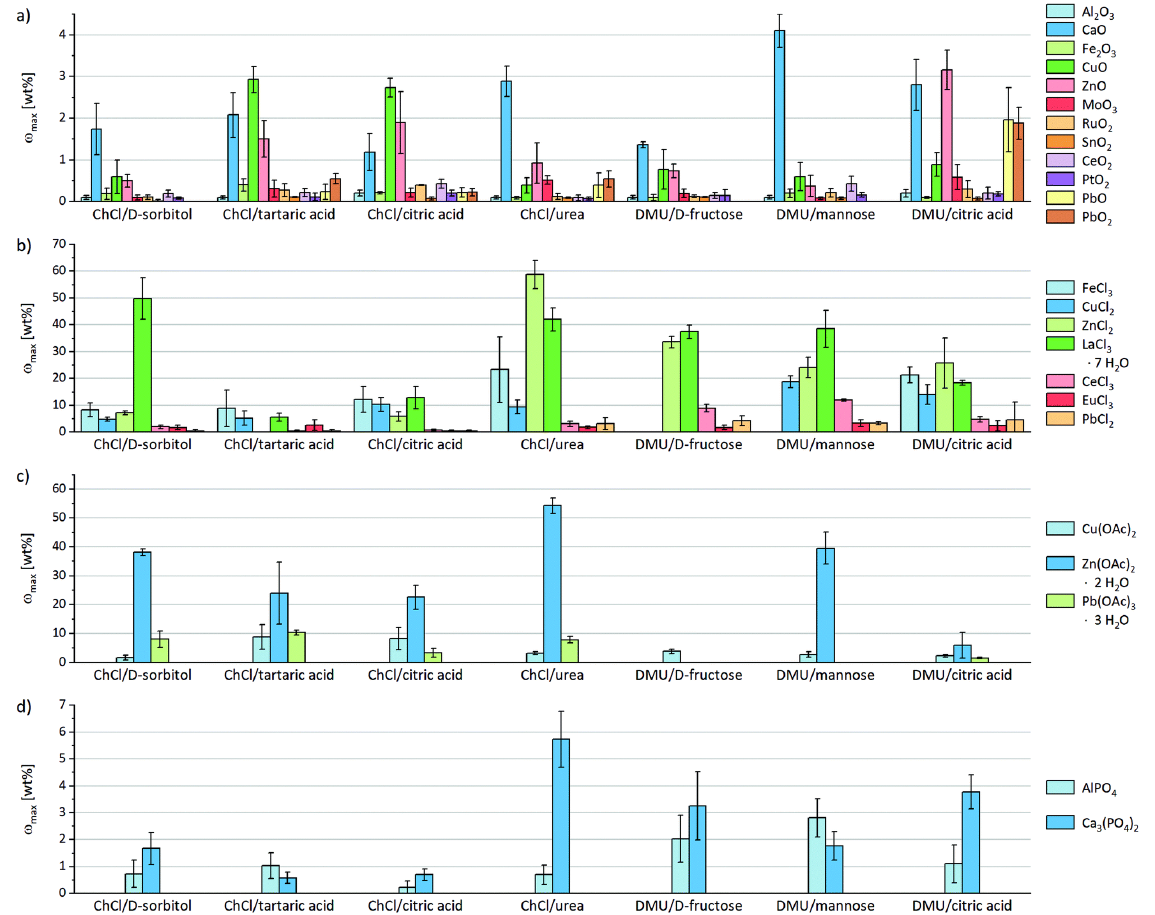
Figure 2. Maximum solubility as the mass fraction ω max (wt%) of metal compounds in seven different DESs: ( a ) oxides; ( b ) chlorides; ( c ) acetates; and ( d ) phosphates. The mass fractions represent an average of three independent measurements. Reprinted from Söldner, A.; Zach, J.; König, B. Deep Eutectic Solvents as Extraction Media for Metal Salts and Oxides Exemplarily Shown for Phosphates from Incinerated Sewage Sludge Ash. Green Chem., 2019, 21 (2), 321–328 with permission from Royal Society of Chemistry